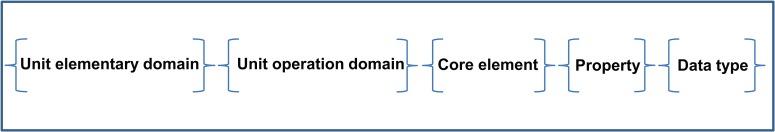
Naming of MOD-CO concepts according a multipartite approach.